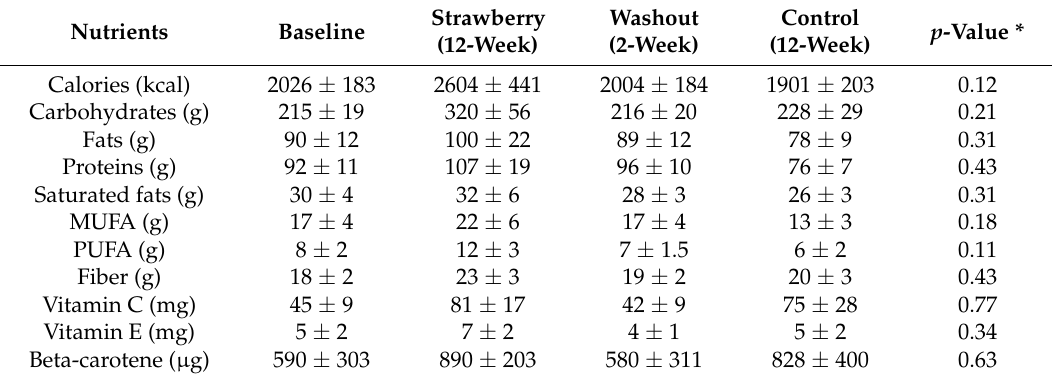
Table 6. Dietary nutrient intakes in a 26-week crossover trial in obese adults with symptomatic knee osteoarthritis ( n =